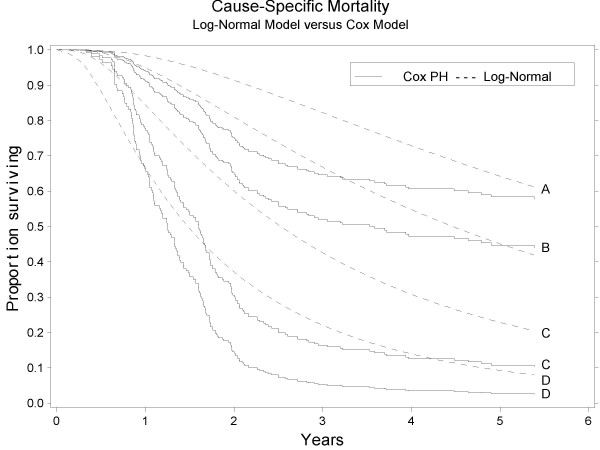
Cause-specific mortality by log-normal and Cox models. 1) Group A, low-risk: complete resection, hemoglobin ≥ 100 for both sexes, no lymph node involvement, no SVC obstruction; 2) Group B, intermediate risk #1: incomplete or no resection, hemoglobin ≥ 100 for both sexes, no lymph node involvement, no SVC obstruction; 3) Group C, intermediate risk #2: incomplete or no resection, hemoglobin < 100 for both sexes, no lymph node involvement, no SVC obstruction; 4) Group D, high-risk: no resection, hemoglobin < 100 for both sexes, lymph node involvement, SVC obstruction.